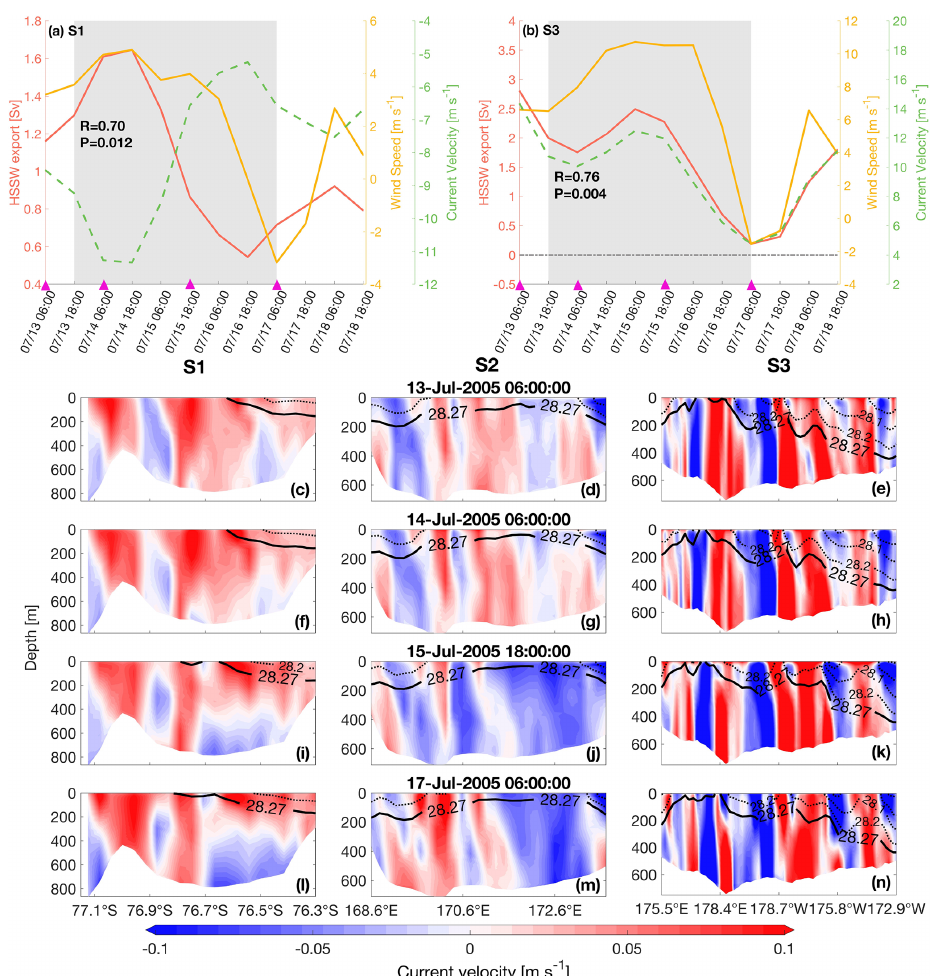
Figure 7. (a) Time series of averaged meridional winds along the S1 transect (see Fig. 1), HSSW exports across the S1, and averaged current velocity along the S1 from 06:00 on 13 July to 18:00 on 18 July 2005. The gray shading represents the time of the SYNO1 event. The correlation coefficient R and P value were calculated between the HSSW export and meridional winds. (b) Same as panel (a) but for S3. (c–n) Vertical sections of cross-transect current velocity (colored shading) and neutral density (contour lines) on (c, f, i, l) S1, (d, g, j, m) S2, and (e, h, k, n) S3 at four selected time moments (indicated by the magenta triangles in panels a and b ). Positive values denote eastward currents for S1 and northward currents for S2 and S3. The bold black line indicates the neutral density contour of 28.27kgm − 3